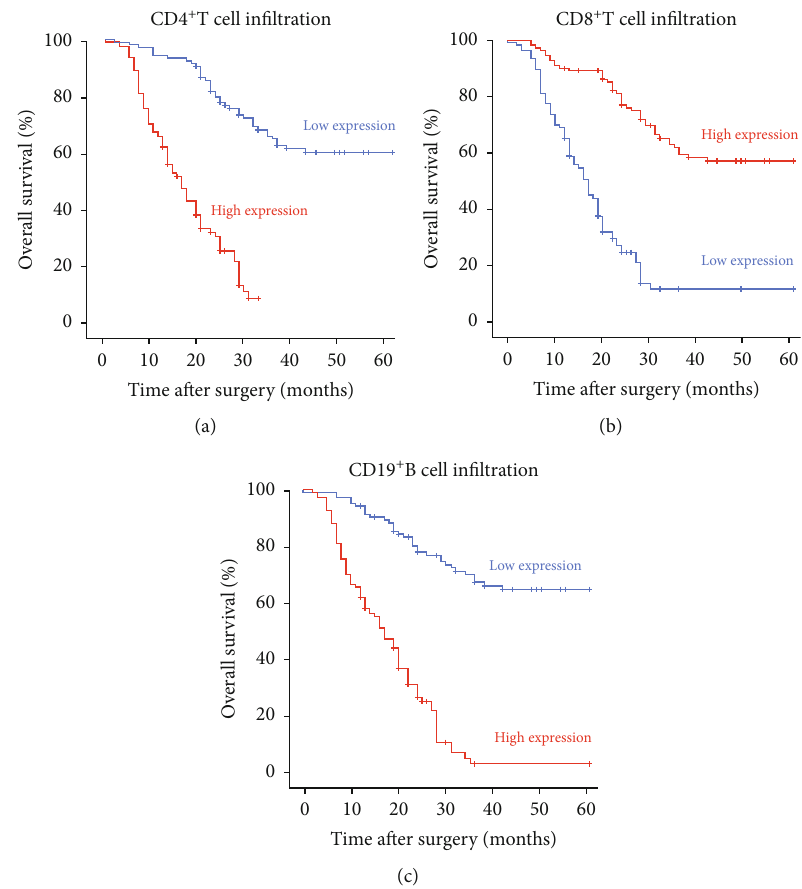
Figure 3: Overall survival of patients with GC strati fi ed by in fi ltration of immune cells in the tumor